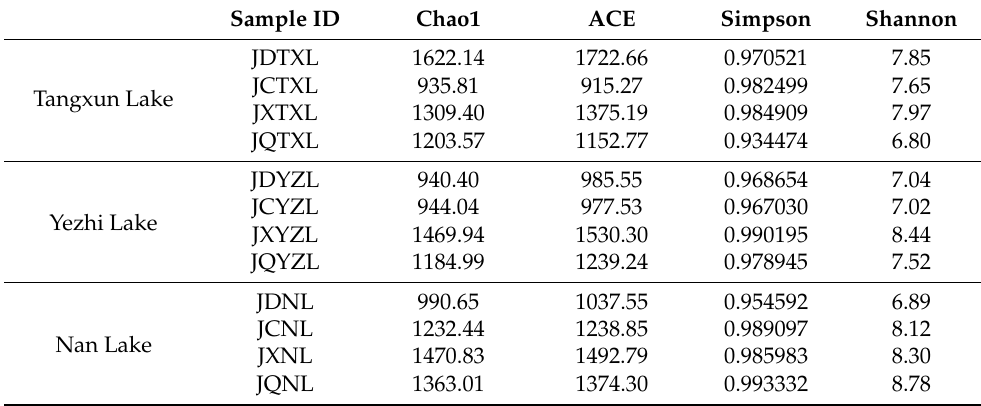
Table 2. The seasonal α -diversity indices of the bacterial community of the three lakes. Sample ID Chao1